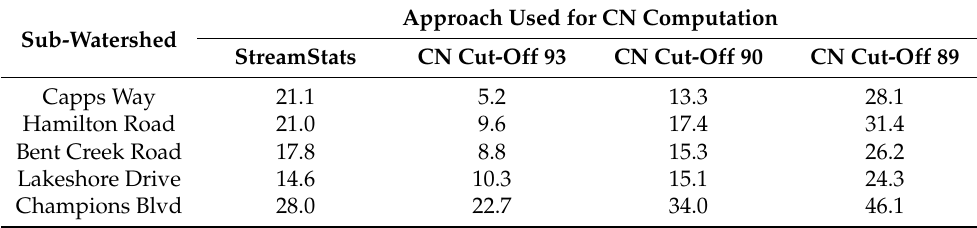
Table 3. Percent imperviousness of